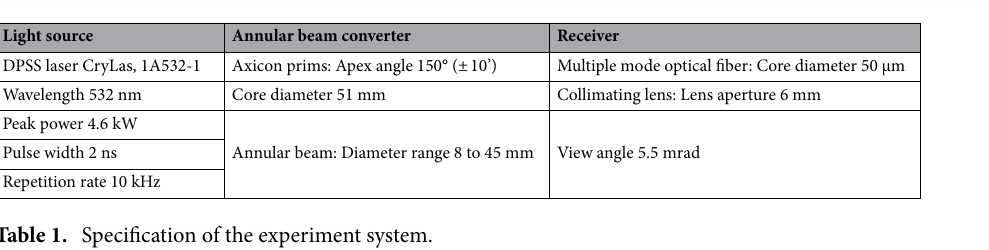
Figure 2. Experimental setup for the annular beam propagation in scattering media. A glass plate (GP) placed in front of the DPSS laser reflects part of the light toward a photodiode (PD), from which the trigger signal is obtained. A neutral-density filter (NDF) and a spatial filter (SF) are placed before the Axicons. The pair of Axicon prisms transforms the Gaussian beam to an annular beam.